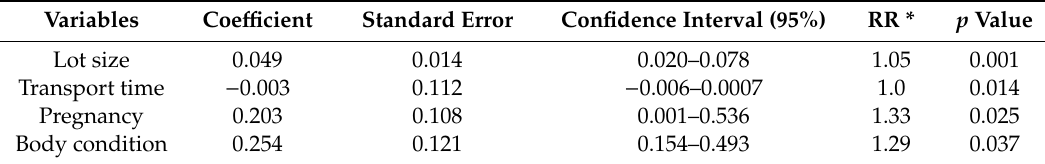
Table 8. E ff ect of the independent variables on total number of bruises of cull cows during pre-slaughter. The model was P ( k events in interval ) = e − λ is the Euler´s number, k takes values 0, 1, 2, ..., and k ! = k × ( k − 1) × ( k − 2) × ... × 2 × 1 is the factorial of k .